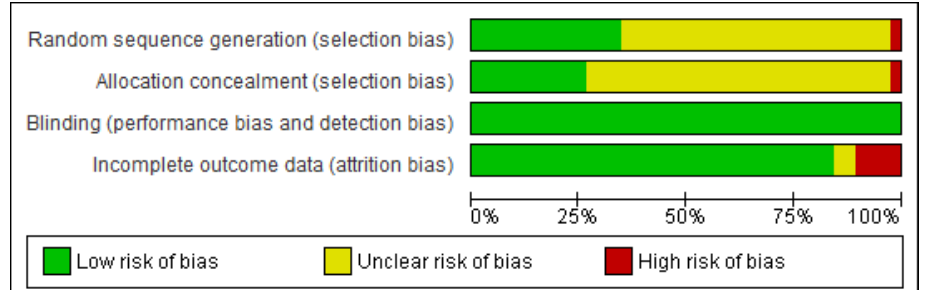
Figure 2. Quality of RCTs included in the